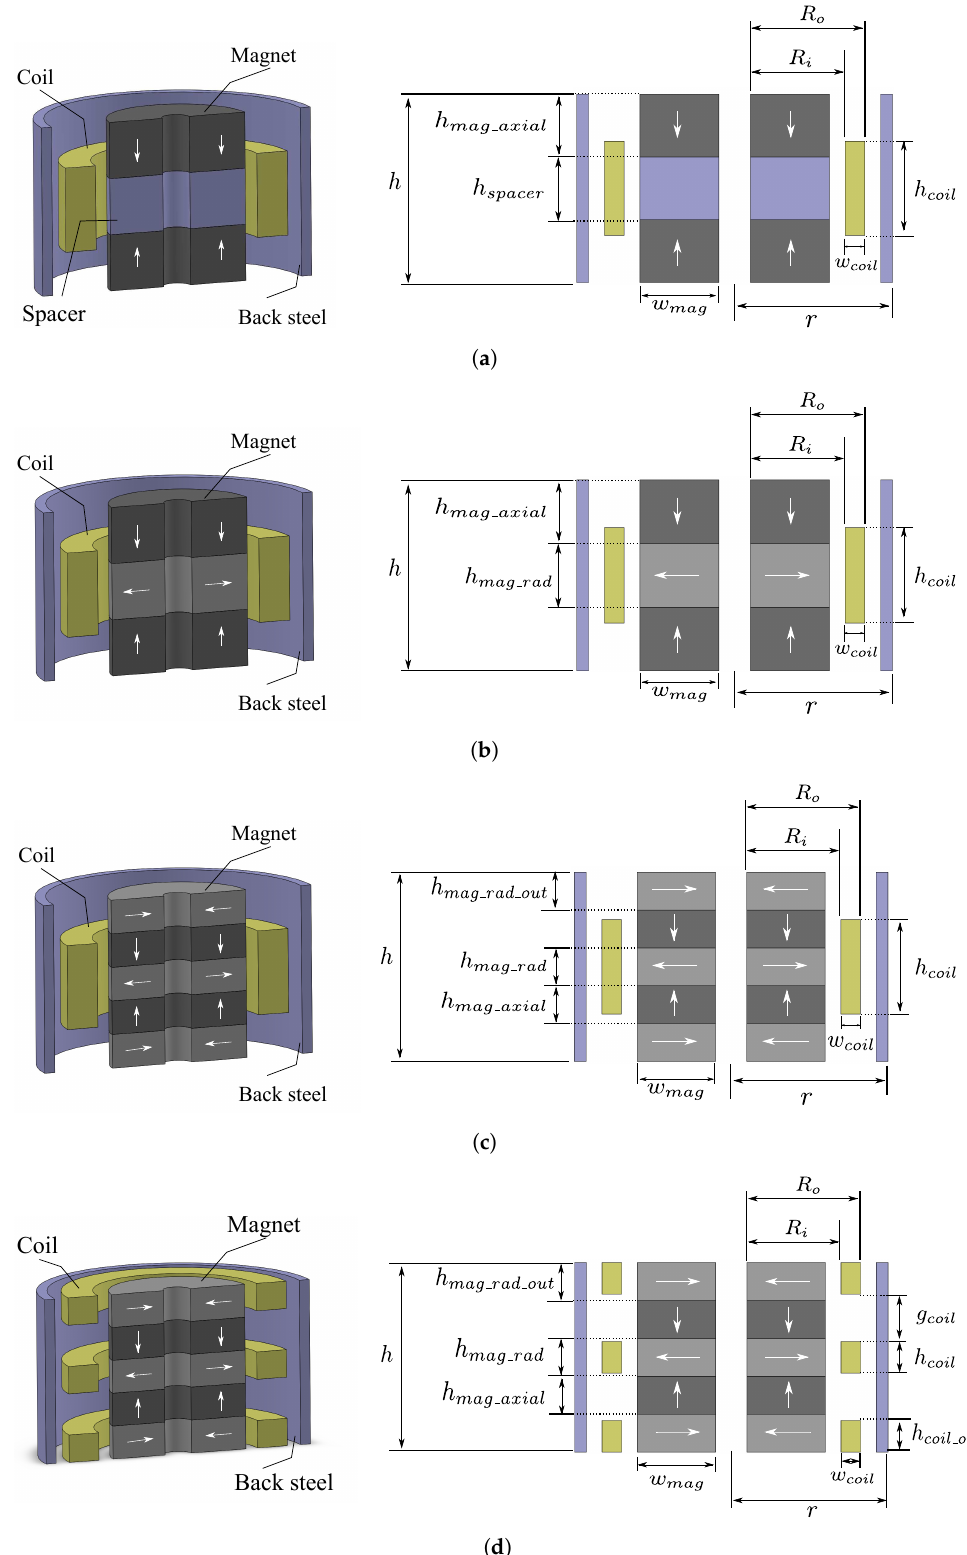
Figure 4. Magnetic structure of the investigated cylindrical electromagnetic energy harvesters: ( a ) Configuration DM1S1C. ( b ) Configuration H3M1C. ( c ) Configuration H5M1C. ( d ) Configuration H5M3C. Right-hand side depicts a 2D representation with relevant